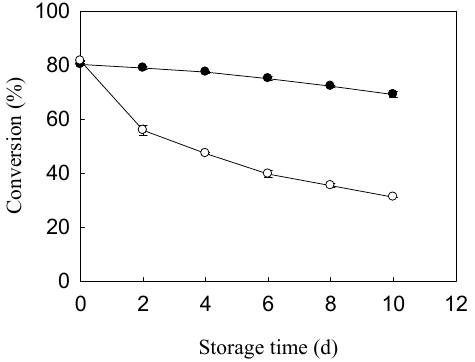
Figure 5. Stability of Pseudomonas cepacia lipase immobilized on magnetic nanoparticles after stored at 4 °C ( ● ) and room temperature ( ○ ) at the time indicated. 40% ( w / w of oil) immobilized lipase was used to catalyze transesterification using 4.8 g waste cooking oil under optimal reaction conditions for 72 h.